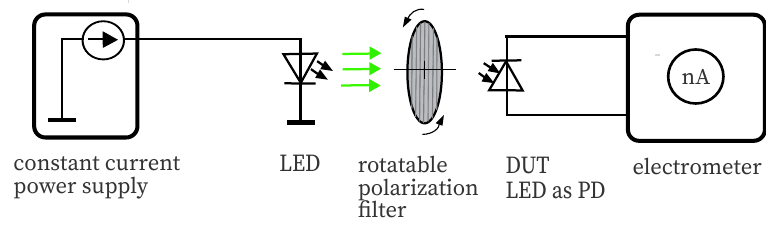
Figure 6. This graphic depicts the setup for checking a possible sensitivity to polarization. The light of a unpolarized LED source is passing a polarization filter. The polarization direction depends on the rotation